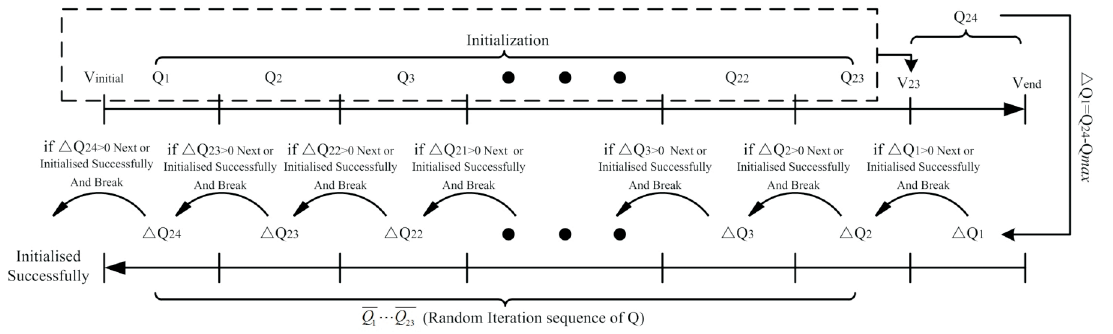
Fig 2. The detailed steps of initial flow